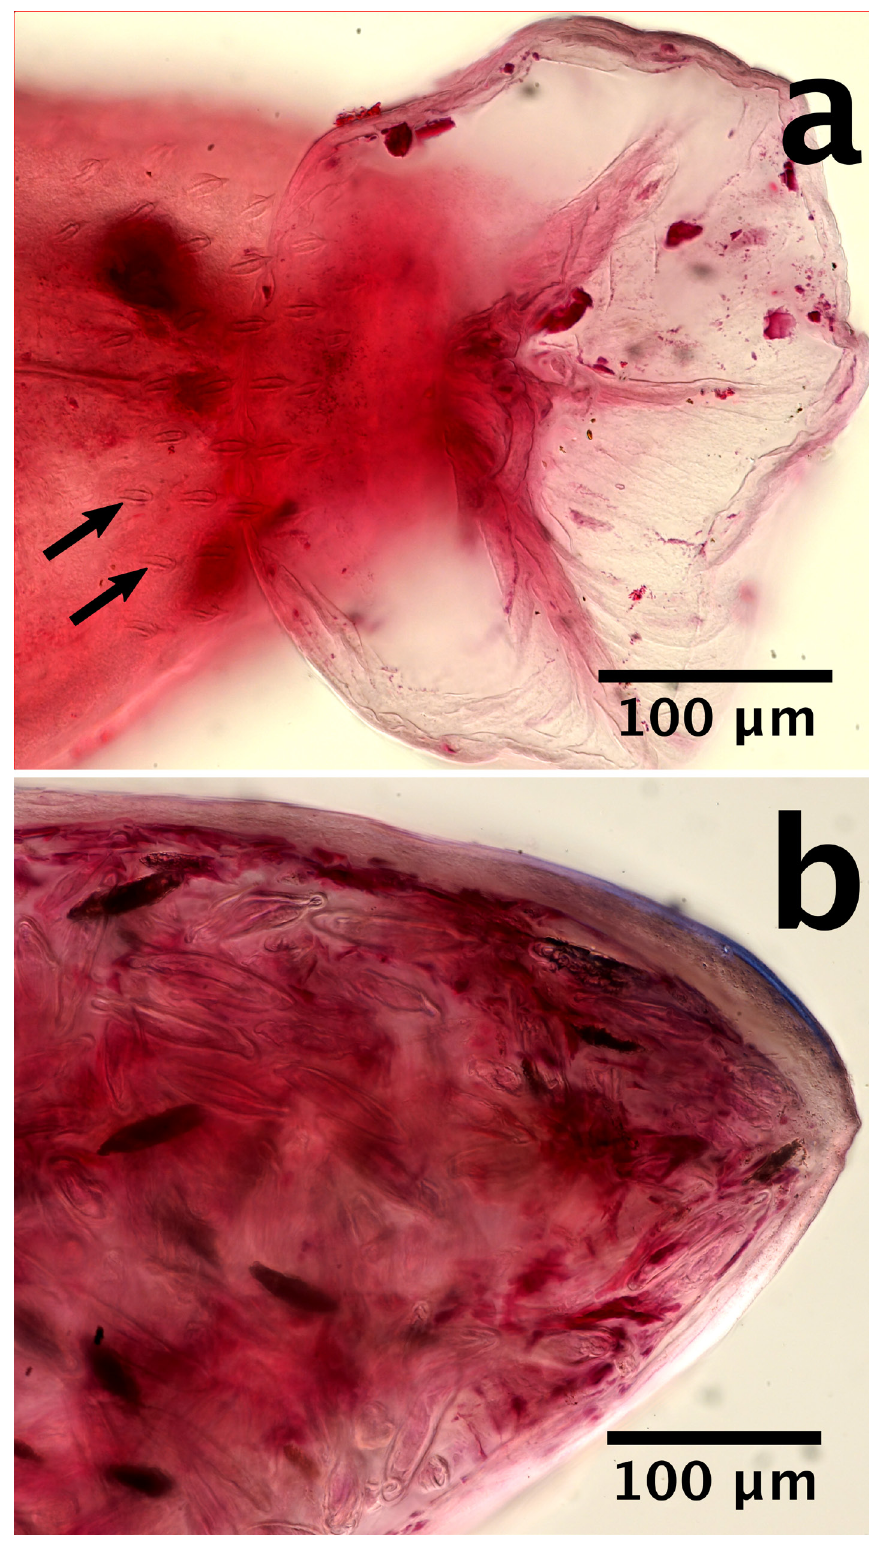
Fig. 4. LM micrographs showing posterior end of Corynosoma magdaleni from a grey seal, Halichoerus grypus, from the archipelago of Åland (Finland). a . ♂ showing everted bursa and genital spine (arrows) (HWML 39480–1041-3). b . ♀ (HWML